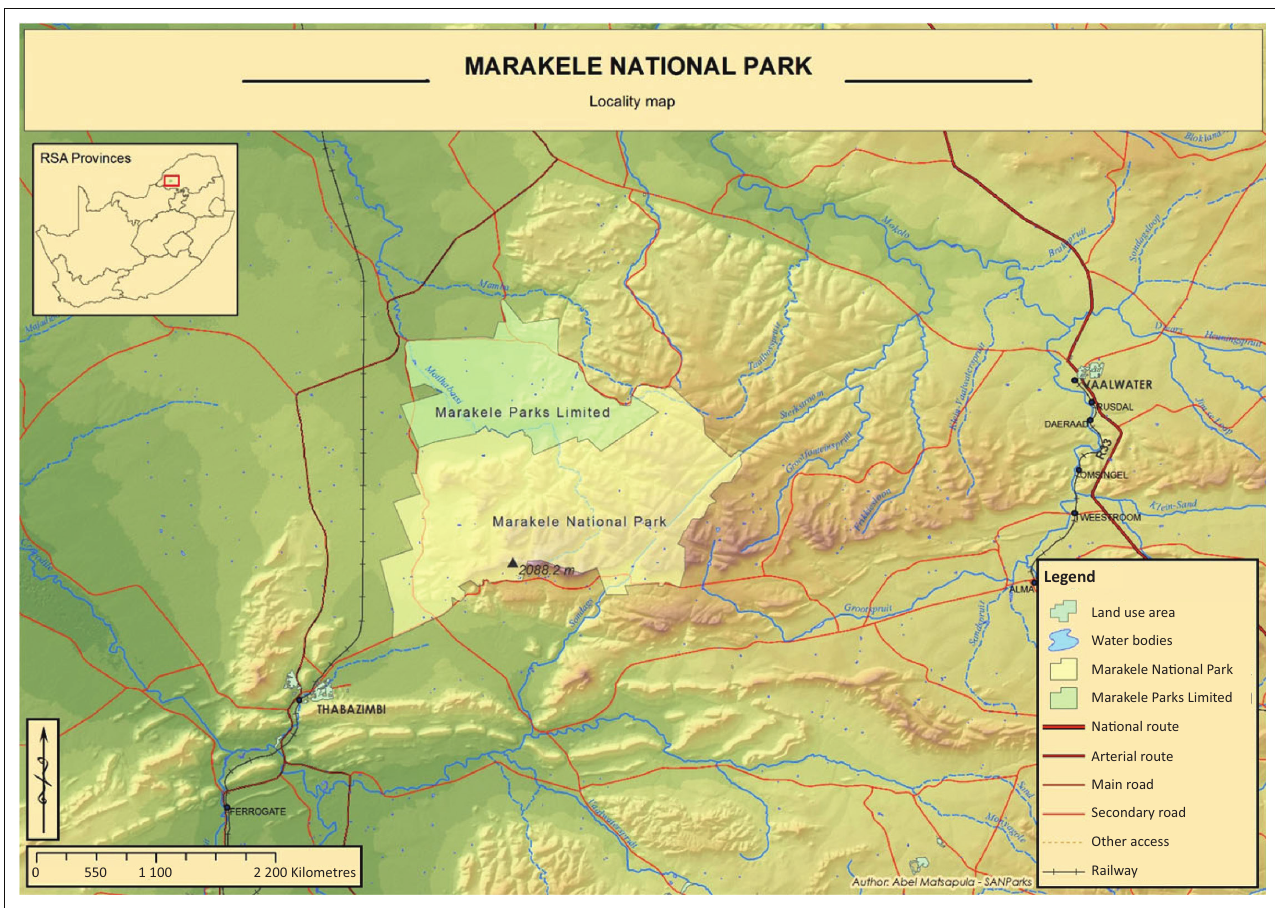
Legend Land use area Water bodies Marakele Na(cid:13)onal Park Marakele Parks Limited Na(cid:13)onal route Arterial route Main